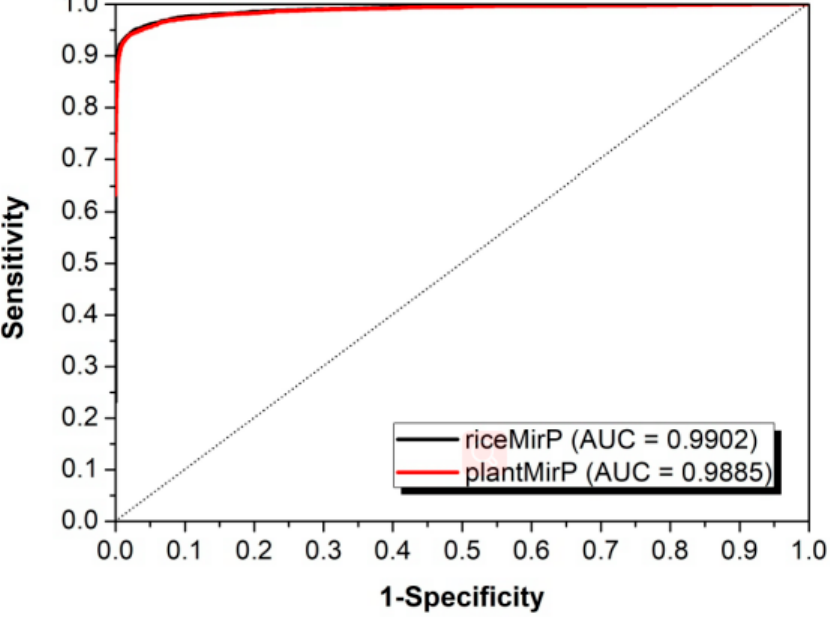
Figure 5. Comparison of riceMirP with plantMirP based on the training dataset of plantMirP.